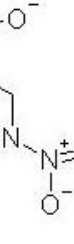
FIGURE 2. Structure of